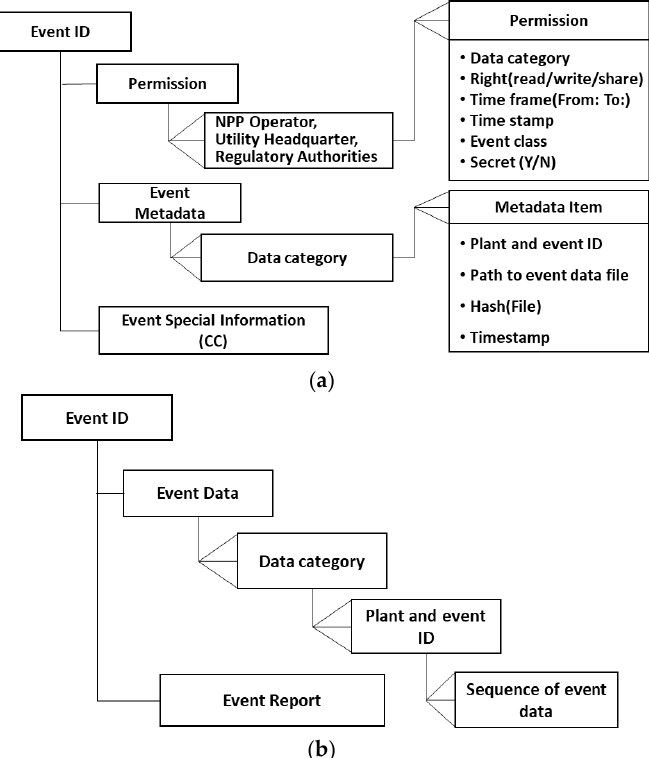
Figure 4. Data structure of an event record. ( a ) The structure of the event metadata stored on the chaincode. CC: chaincode; ( b ) The structure of the event data stored on the DREAMS server.